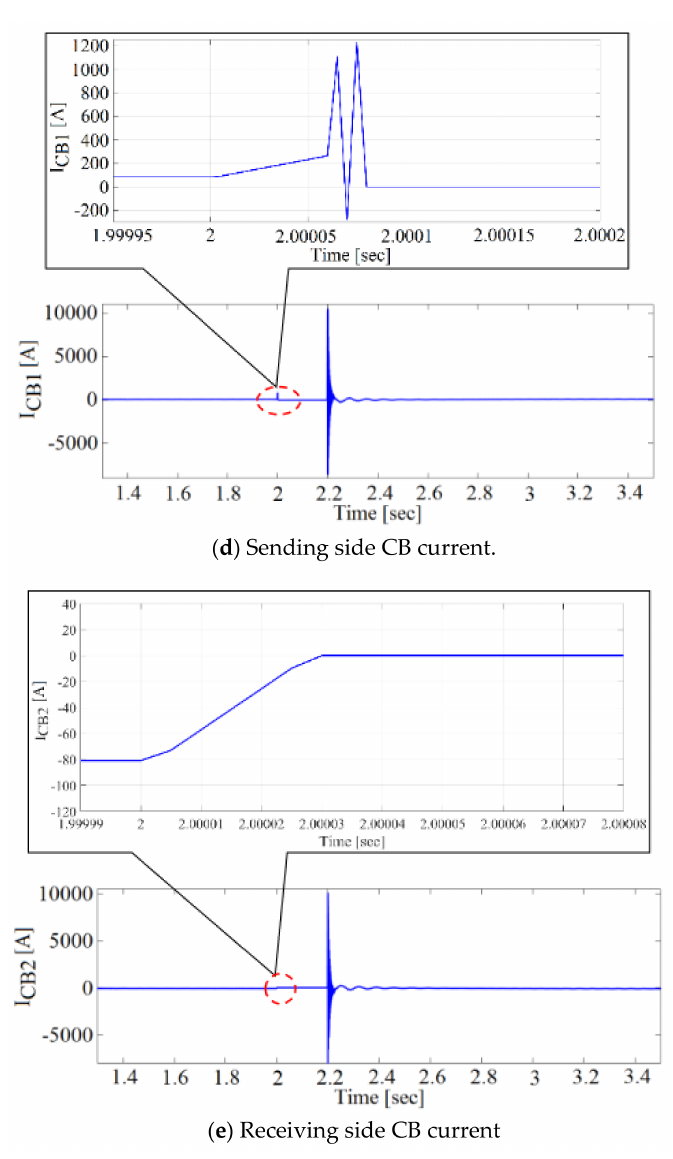
Figure 16. Simulation results of LC resonance